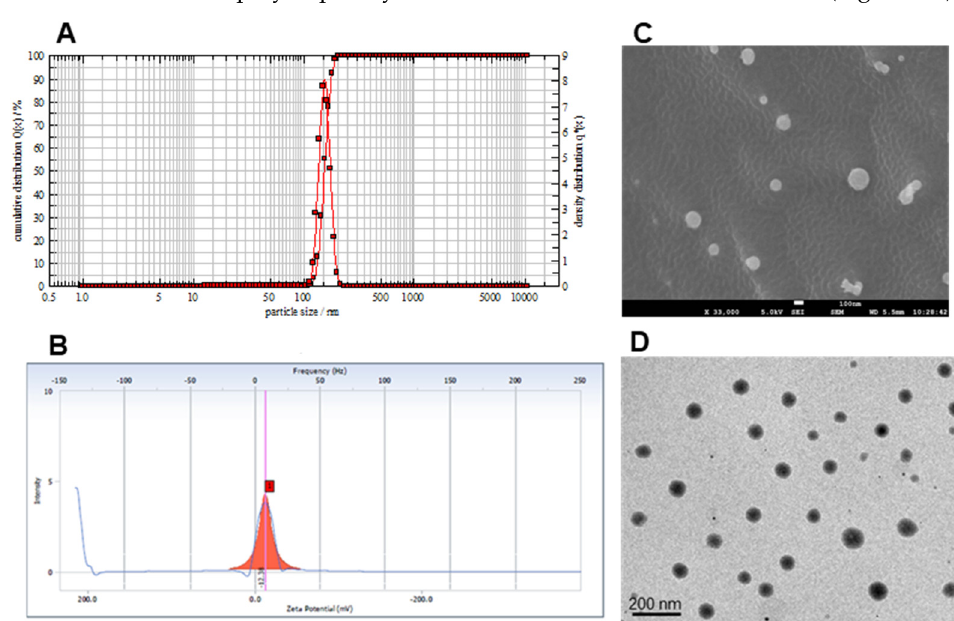
Figure 3. Droplet size analysis ( A ), Zeta potential ( B ), SEM image (Scale 5mm = 100 nm) ( C ) and TEM image (Scale 1 cm = 200 nm) ( D ) of nanoemulsion of naringin obtained after dilution of self-emulsifying preconcentrate of naringin with water.